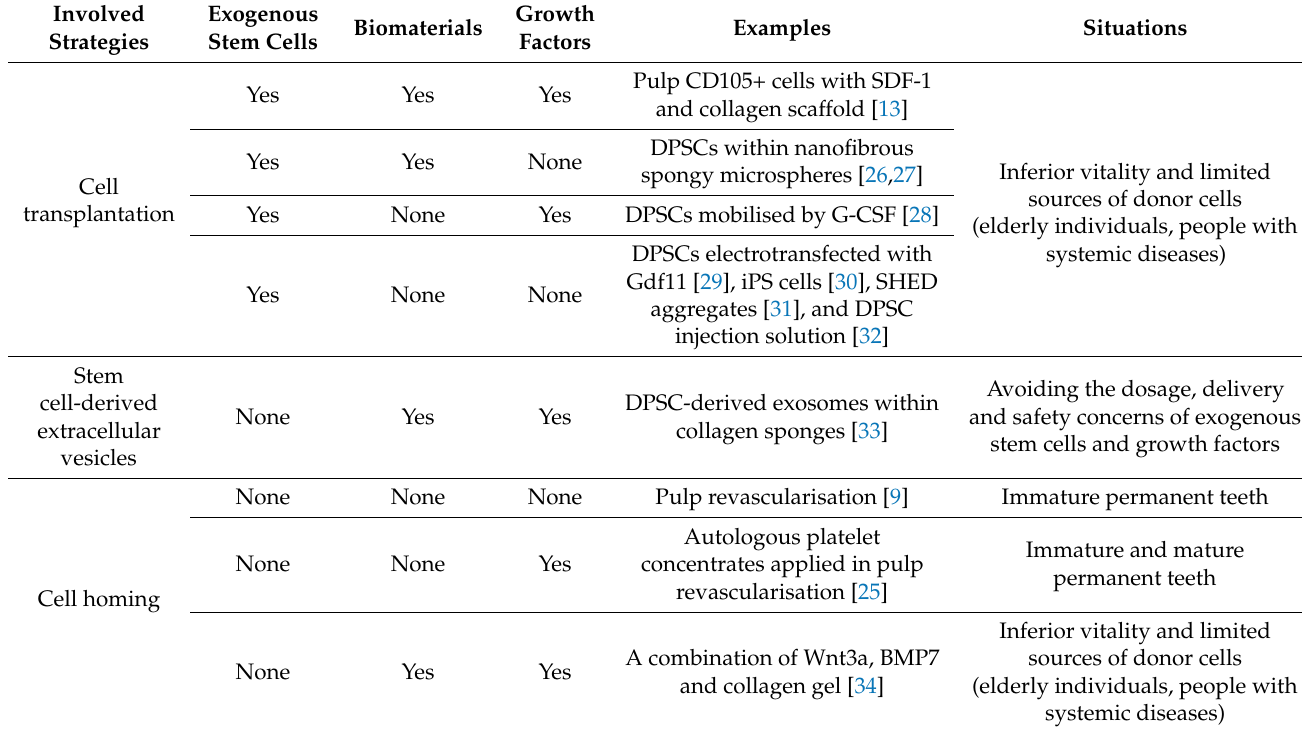
Table 2. Therapeutic applications of the three essential elements.